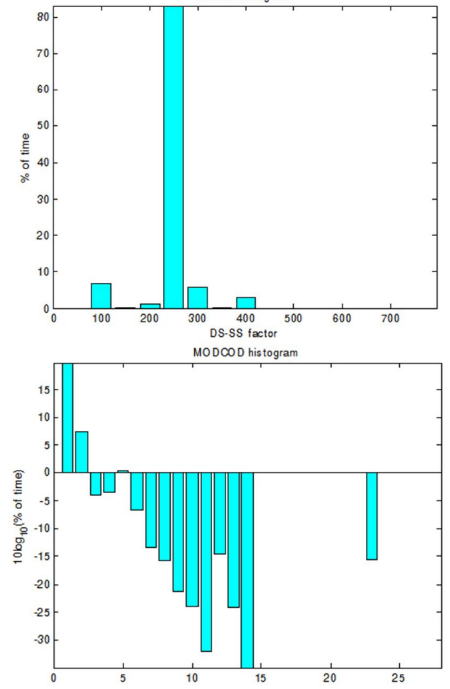
Figure 10. (a) Histogram of DS-SS factor values for UTD terminals in V band (left). (b) Histogram of MODCODs for UTD terminals in V band